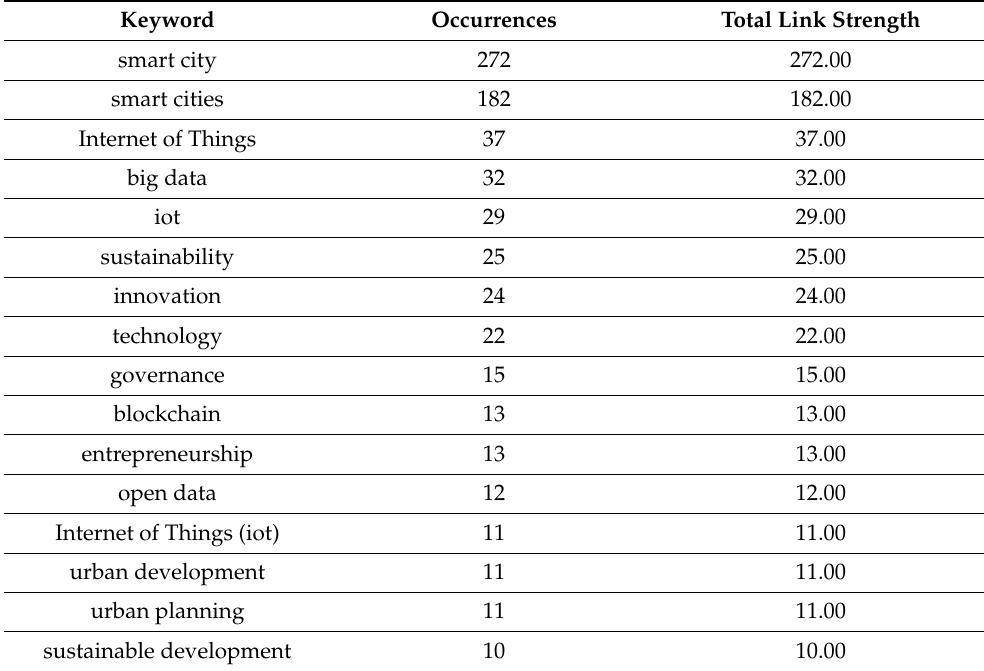
Table 5. The most popular keywords with the highest level of occurrence and total link strength.